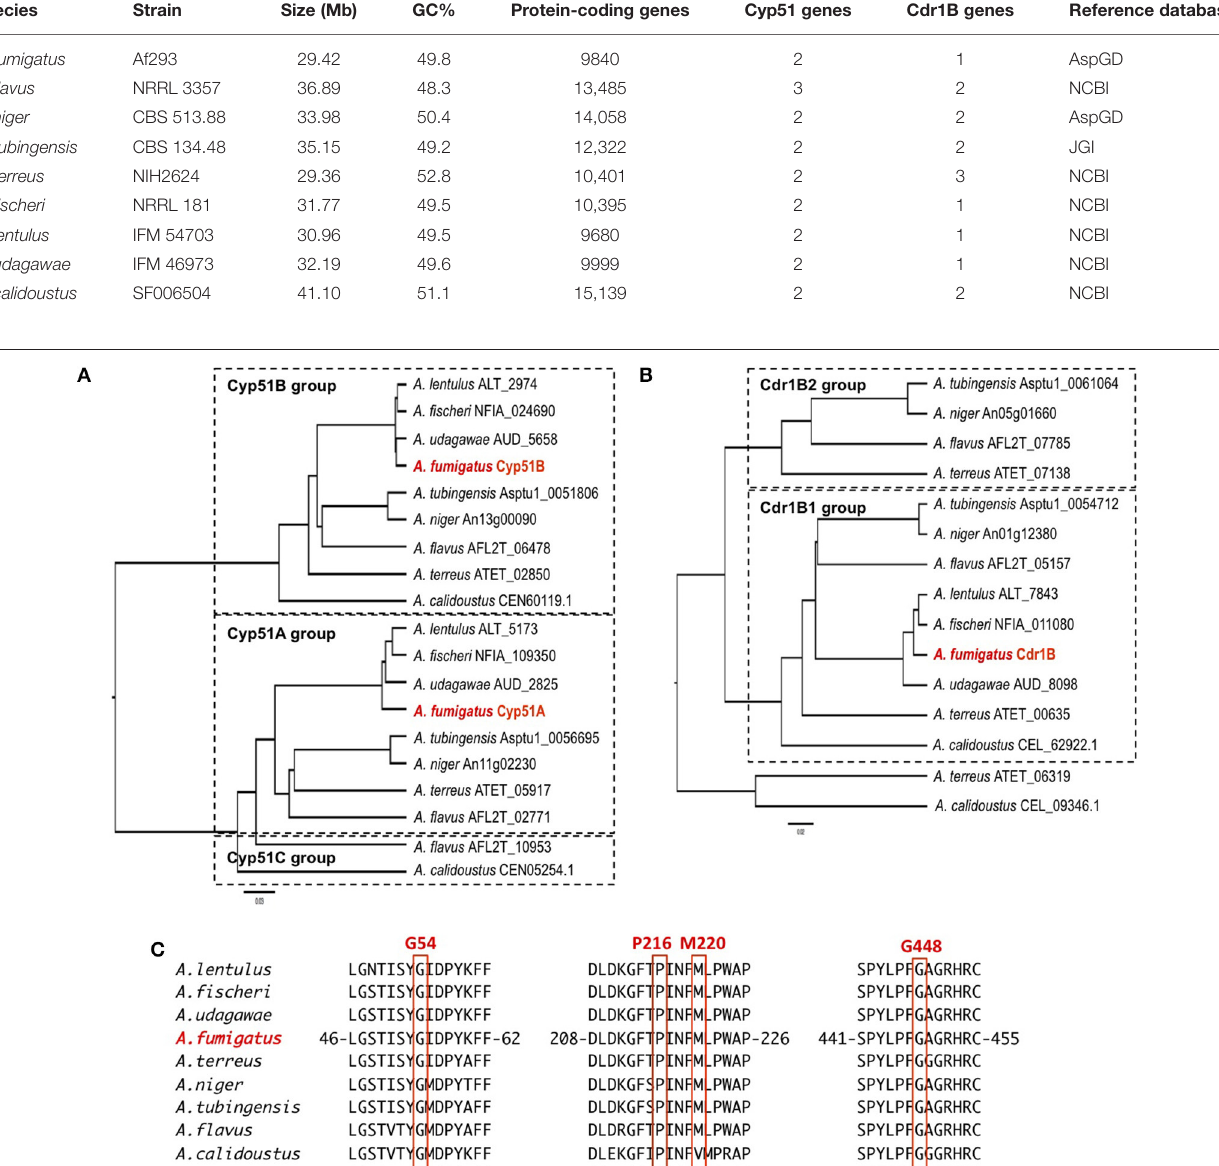
TABLE 4 | Features of pathogenic Aspergillus genomes. Species